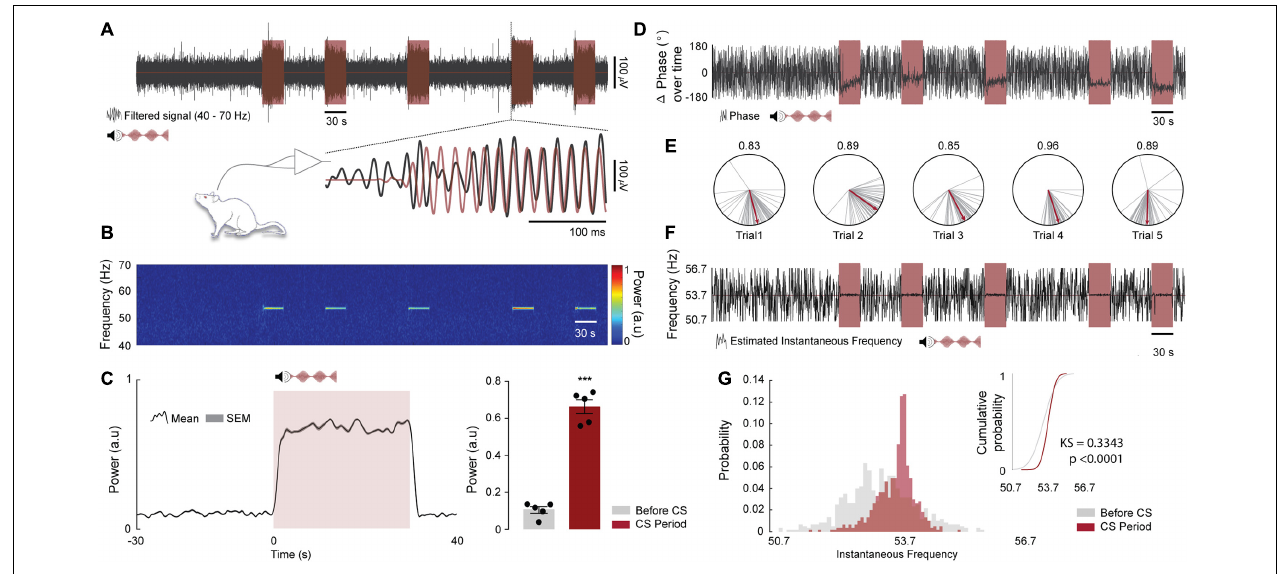
FIGURE 7 | Oscillations in the IC can be entrained by the envelope of an amplitude modulated tone. ( A , top) Representative time course of LFP (gray) and CS trials (light red, 10 kHz pure tone with an amplitude modulation of 53.7 Hz). ( A , Bottom) Highlight to a sample time window at the beginning of the fourth trial showing that the IC LFP synchronizes with the CS amplitude envelope. The LFP and the CS envelope were band-pass filtered between 40 and 70 Hz. (B) Spectrogram showing SSEP power at 53.7 Hz (a.u., Arbitrary units). ( C , left) Mean SSEP power at 53.7 Hz ± 3 Hz over trials for all animals. The figure shows a period of 30 s before CS onset, 30 s of CS presentation and 10 s after. ( C , right) Qualitative analysis of SSEP power at 53.7 Hz ± 3 Hz for 30 s before CS onset compared to the 30 s of CS presentation ( n = 5 animals; before CS vs. CS period; t ( 4 ) = 11.42, p = 0.0003). (D) Representative time course of delta phase values at 53.7 Hz ± 3 Hz ( ϕ SSEP − ϕ CS ) extracted from the Hilbert coefficients (gray) and CS trials (light red). (E) Delta phase vectors computed for 250 ms time windows during CS presentation (gray lines) and the respective estimate mean phase values (red lines). The numbers above the polar plots represents the phase coherence of each trial during CS presentation. (F) Representative time course of instantaneous oscillatory frequency estimated at 53.7 Hz ± 3 Hz from the changes in the SSEP phase angles (gray) and CS trials (light red). (G) Distribution of instantaneous oscillatory frequencies over trials for 30 s before CS onset (light gray) and 30 s of CS presentation (light red) and their respective cumulative distributions. Two Sample Kolmogorov–Smirnov test was used to test whether the two samples come from the same distribution ( n = 5 animals; before CS vs. CS period delta phase angles distributions; KS = 0.3343, p <